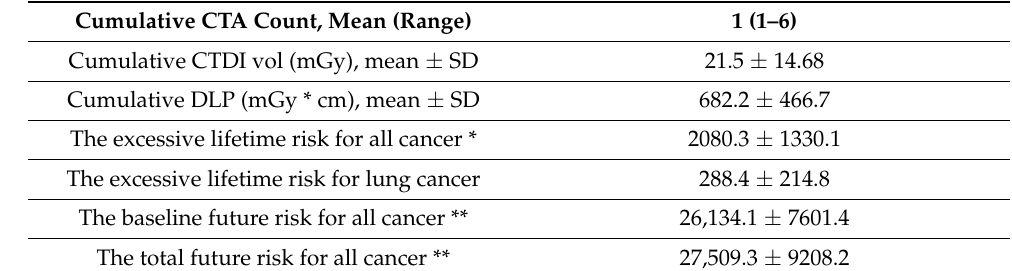
Table 3. Summary data for CTA counts, radiation dose, the excessive lifetime risk of all cancer, excessive lifetime risk for lung cancer, the baseline future risk for all cancer, and the total future risk (per